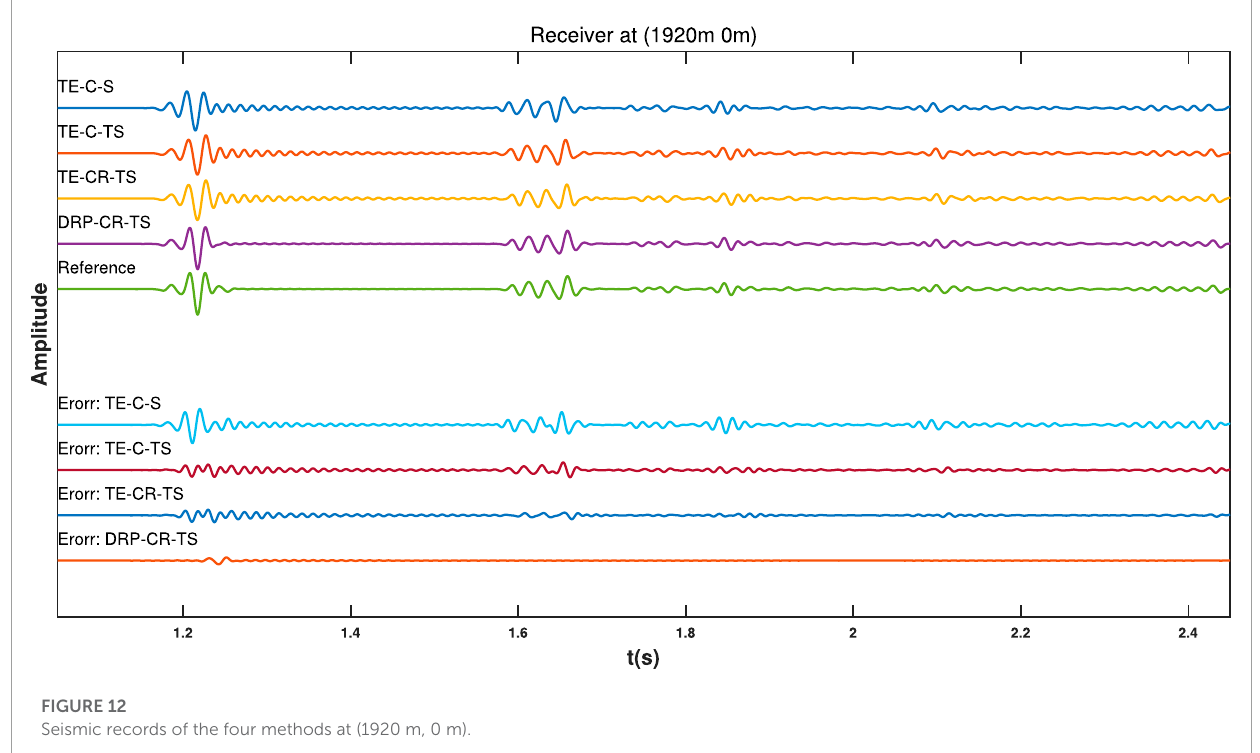
FIGURE 12 Seismic records of the four methods at (1920 m, 0 m).